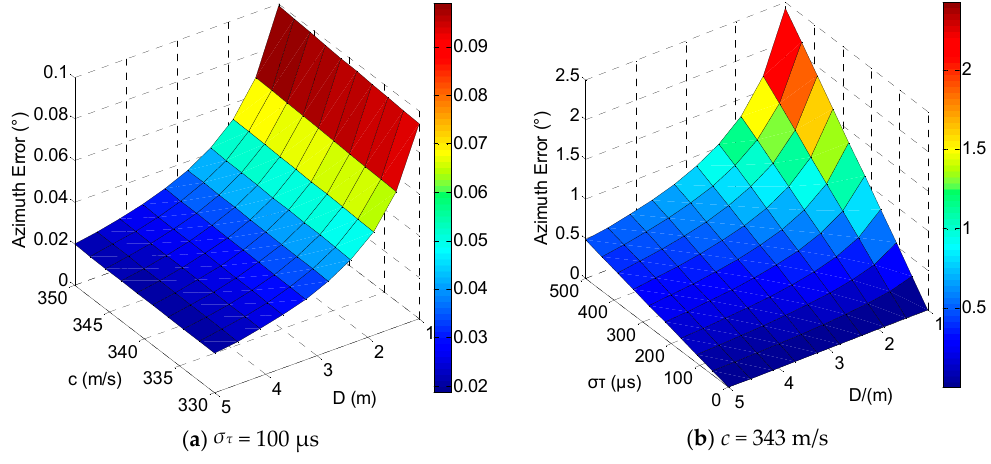
Figure 2. Distribution of azimuth error of c and σ τ .